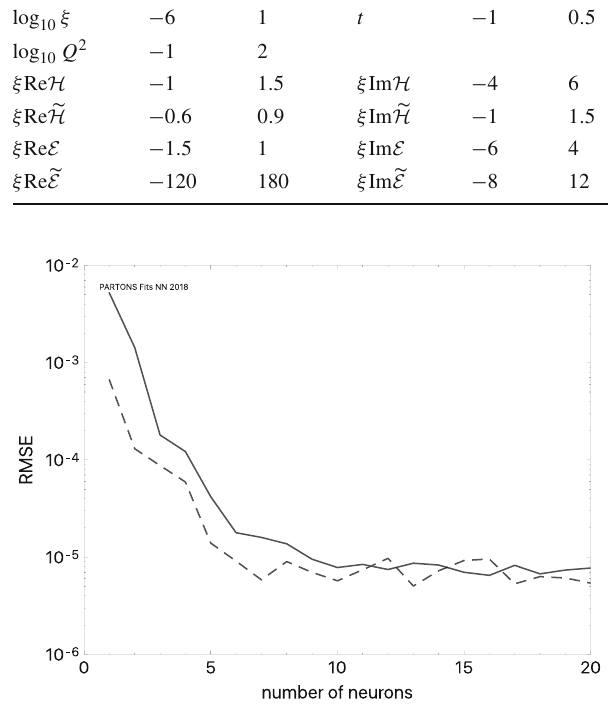
Fig. 7 Average root mean square error (RMSE) for the neural network describing the benchmark sample (see the text) as a function of the number of hidden neurons in that network for the real (solid line) and imaginary (dashed line) parts of CFF H . The RMSE values correspond to the normalized variables, see Table